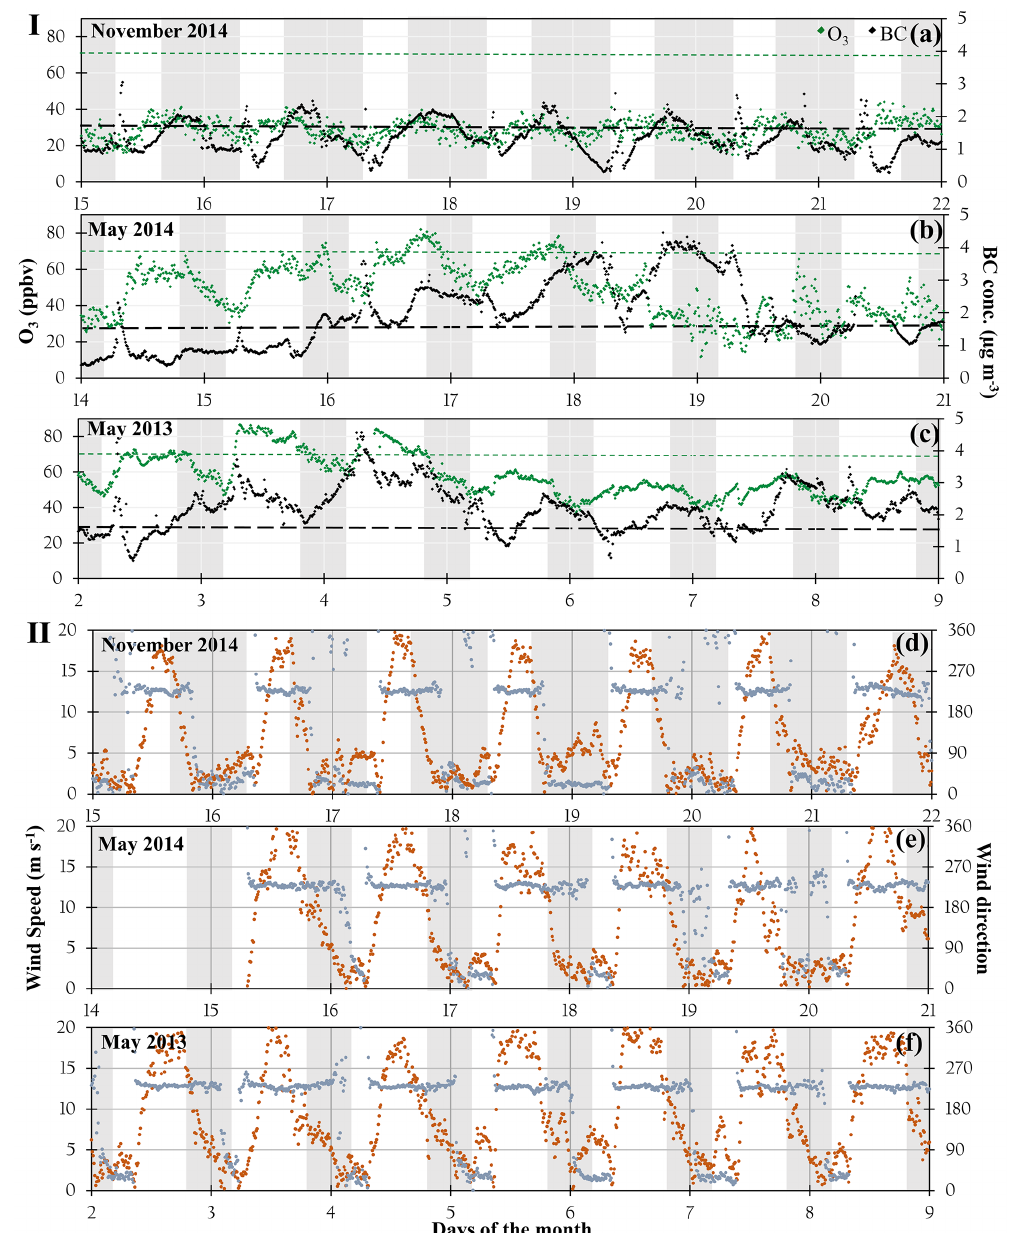
Figure 8. (I) Examples of extended periods with relatively high BC and O 3 concentrations at JSM_STA during November 2014 (a) , May 2014 (b) , and May 2013 (c) . The dashed black and green lines depict 2-year averages for BC and O 3 , respectively. (II) Corresponding wind direction and wind speed during the episodes of high BC and O 3 . The orange dots represent wind speed, and the blue dots represent wind